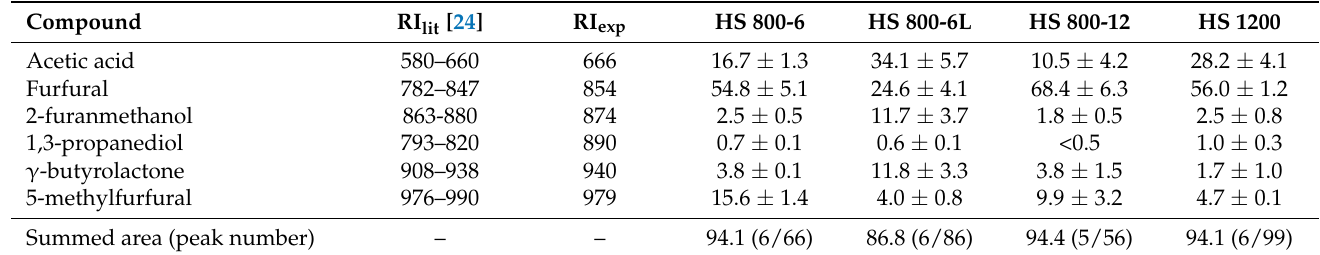
Table 2. The most abundant identified VOCs and their relative area % from the total peaks in